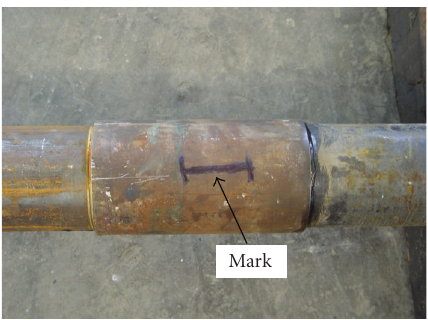
Figure 14: Orientation mark of casing pipe.